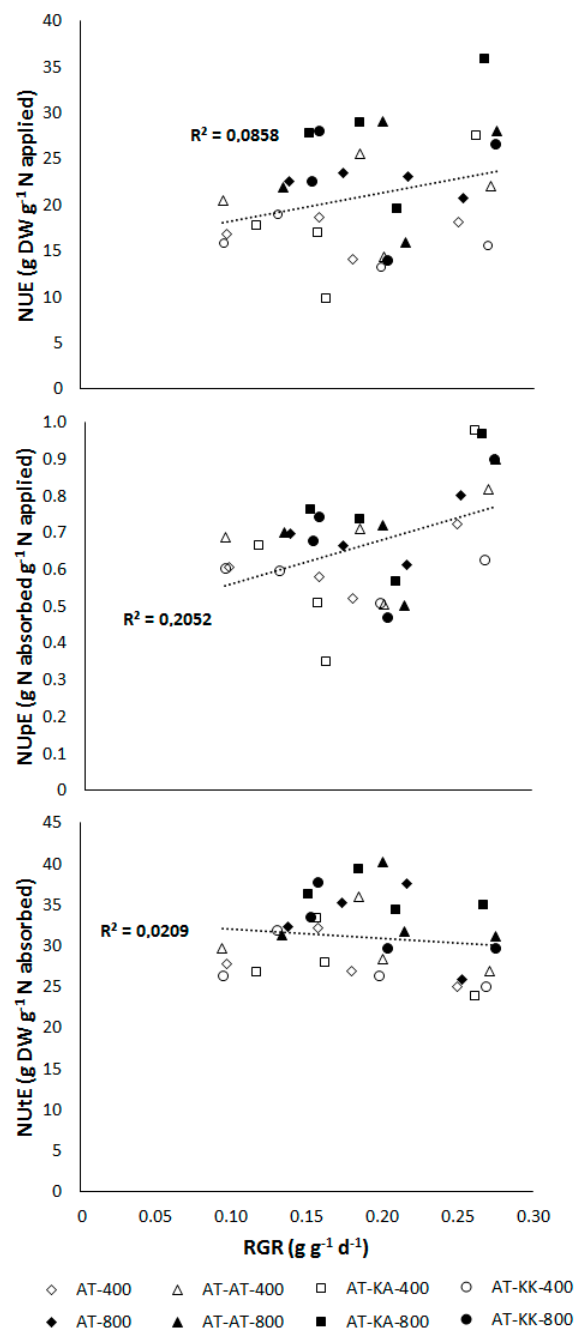
Figure 2. Relationship between nitrogen-use (NUE; top), -uptake (NUpE; middle), and, -utilization efficiency (NUtE; bottom) to relative growth rate (RGR) in plants at the vegetative stage. Open symbols denote measurements under medium (400 µmol m − 2 s − 1 ) light intensity, solid symbols represent measurements under high (800 µmol m − 2 s − 1 ) light intensity.